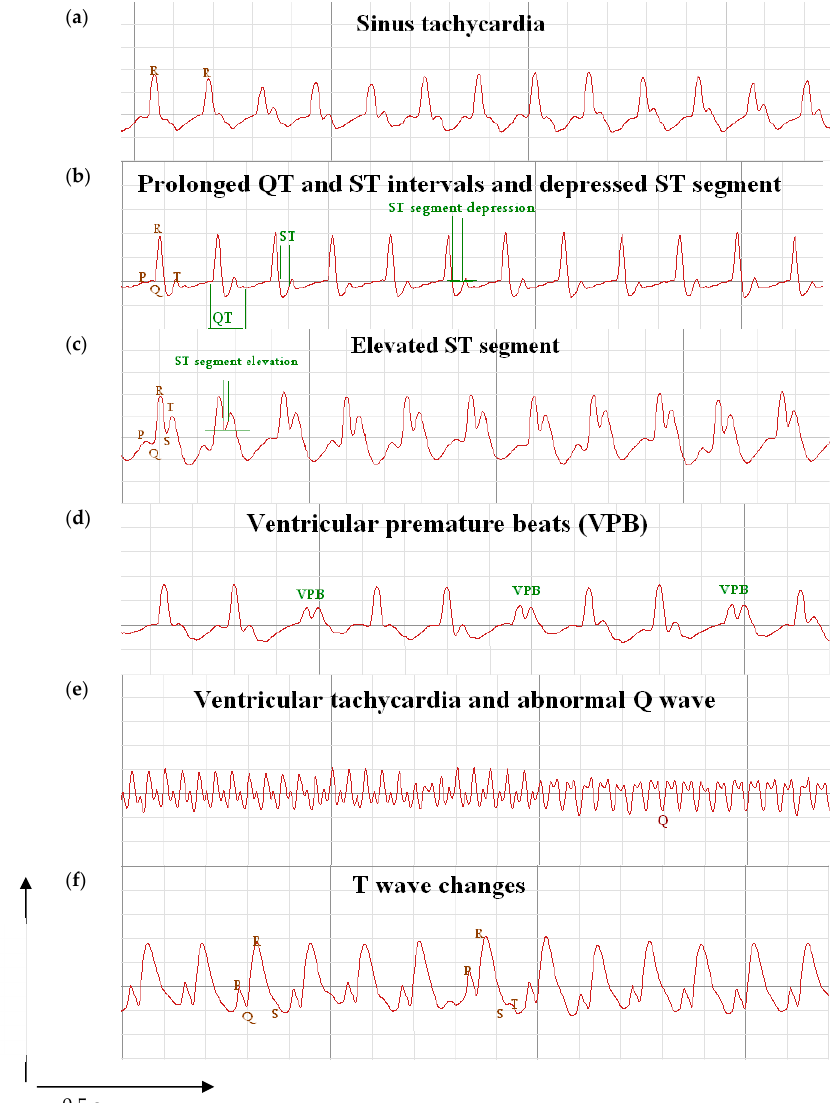
Figure 2. Electrocardiograms from rats with isoproterenol hydrochloride treated group. Rats were subjected to ECG recording under ether anesthesia in the Biopac data acquisition mp150 device. The figure represents electrocardiograms for rats with myocardial infarction group showing ( a ) tachycar- dia, ( b ) QT prolongation and depressed ST, ( c ) ST-segment elevation, ( d ) ventricular premature beats, ( e ) abnormal Q wave, and ( f ) T wave